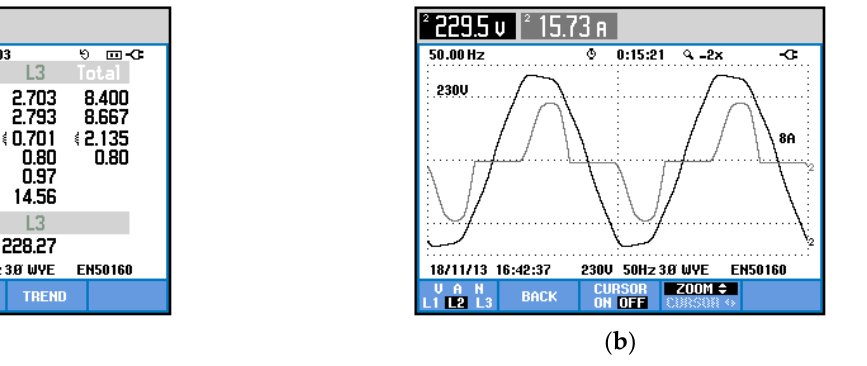
Figure 39. Case 4 - without filters with unbalanced loads: ( a ) source power; ( b ) voltage and current waveforms in phase S .